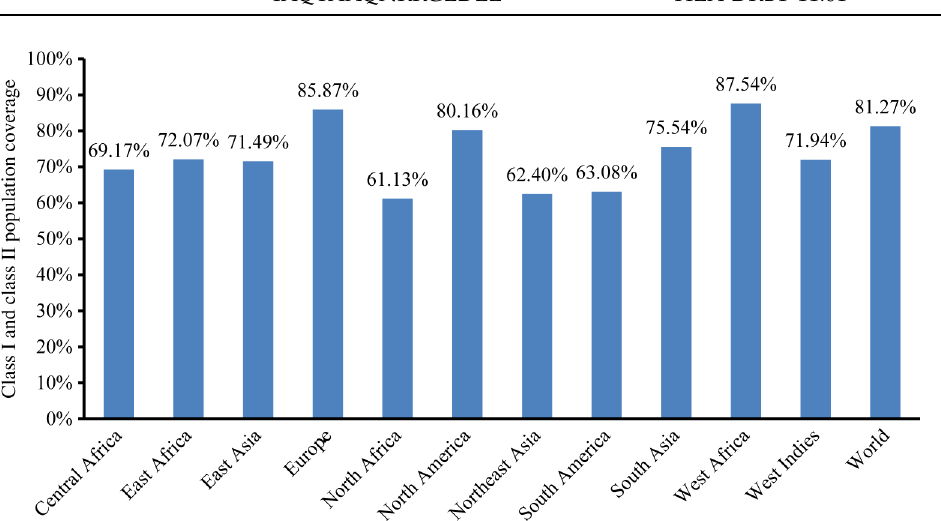
Figure 2: Population coverage by MHC Class I + II restricted epitopes from envelope Glycoprotein GP62 of